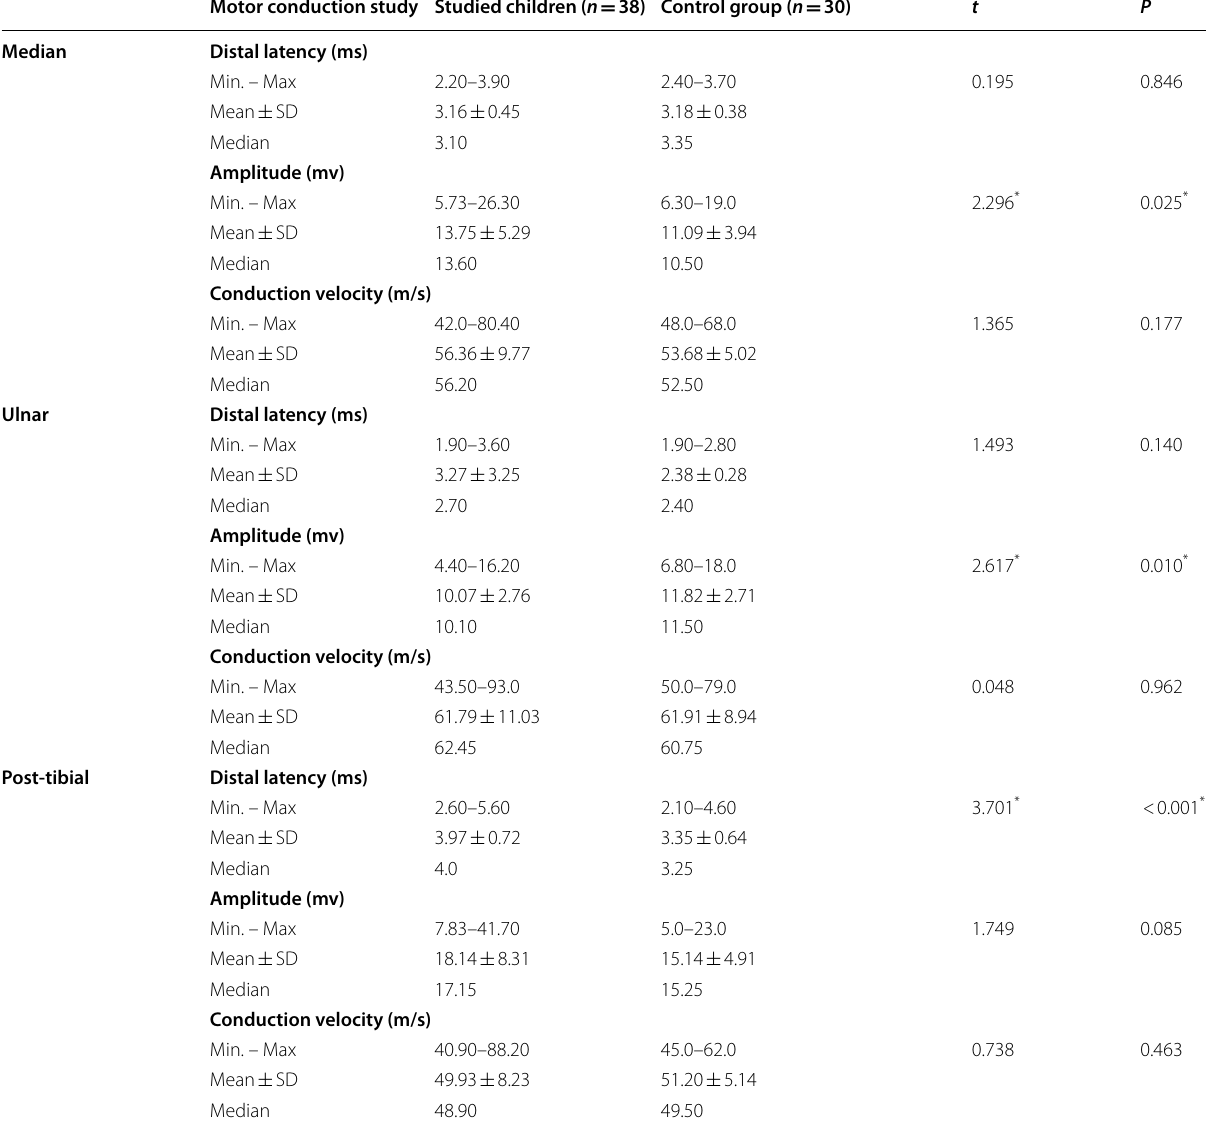
t Student’s t test . P P value for comparing between the two groups * Statistically significant at P ≤